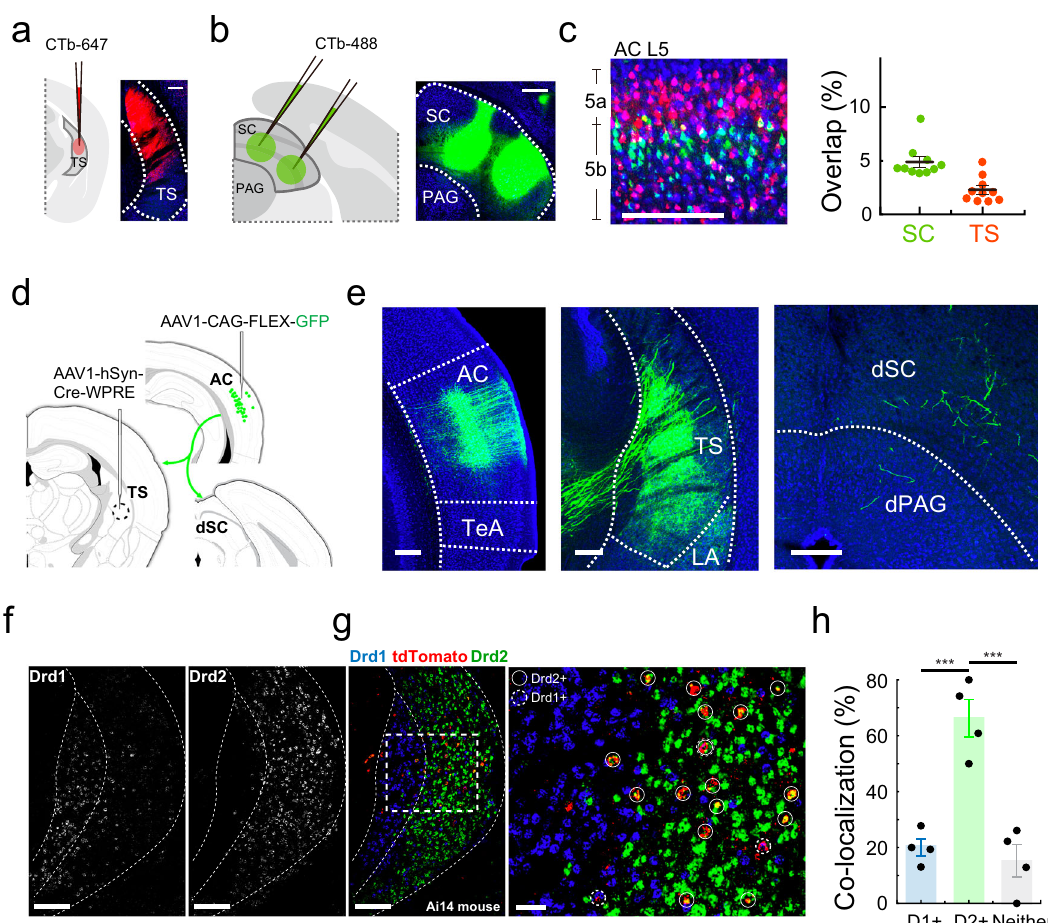
Fig. 6 SC- and TS- projecting corticofugal neurons and targets. a Injection of CTb-647 (red) into TS. Scale, 200 µ m. TS the tail of the striatum. b Injection of CTb-488 (green) in SC in the same animal. Scale, 200 µ m. SC superior colliculus, PAG periaqueductal gray. c Left, retrogradely labeled TS-projecting (red) and SC-projecting (green) neurons in layer 5 (L5) of auditory cortex (AC). Scale bars, 200 µ m. Right, overlap between the two groups of projecting neurons (overlap ratio: 4.9 ± 0.5% in SC-projecting neurons. 2.3 ± 0.4% in TS-projecting neurons, n = 10 sections). Data are presented as mean ± s.e.m. The center presents the mean value and the bar represents s.e.m. d Viral injections in TS and AC to label TS-projecting AC neurons. e Retrogradely labeled TS-projecting neurons in AC (left) and their axon terminals in TS (middle) and SC (right). Scale bars, 200 µ m. TeA temporal association cortex, LA lateral amygdala, dSC deep layers of the superior colliculus, dPAG dorsal periaqueductal gray. The result was consistent in three mice. f Distribution of Drd1 + (left) and Drd2 + (right) neurons in TS. Scale bars, 200 µ m. g AC-receipt neurons (tdTomato, red) and Drd1 + (blue) or Drd2 + (green) neurons in TS. Scale bars, 200 (left) and 50 (right) µ m. h Percentage of AC-receipt neurons overlapping with D1 + (i.e. Drd1 + ) neurons, D2 + (i.e. Drd2 + ) neurons or neither. D1 + vs. D2 + , *** p = 5.875 × 10 − 4 ; D2 + vs. Neither, *** p = 2.827× 10 − 4 , one-way ANOVA with post hoc (Bonferroni) test, n = 4 sections. Data are presented as mean ± s.e.m. The center presents the mean value and the bar represents